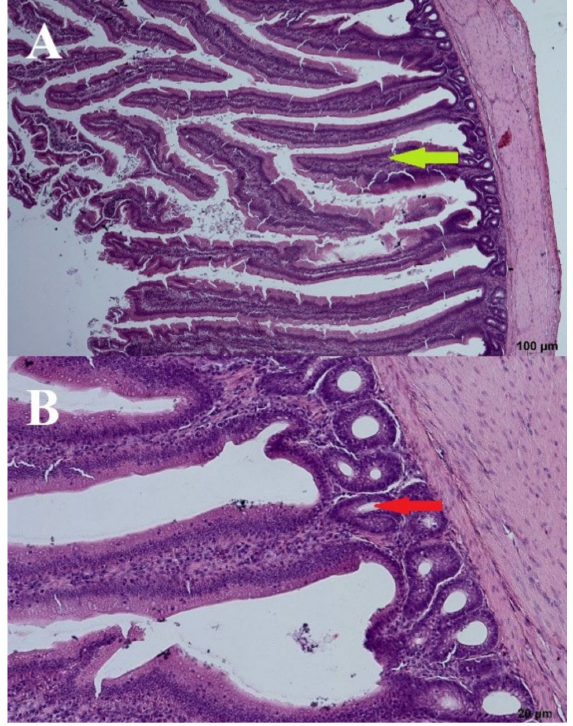
Figure 7. B. subtilis 87Y—( A ). Cross section through the intestine—100 µ m and ( B ). crypts—20 µ m. Arrows: bold green—villi,